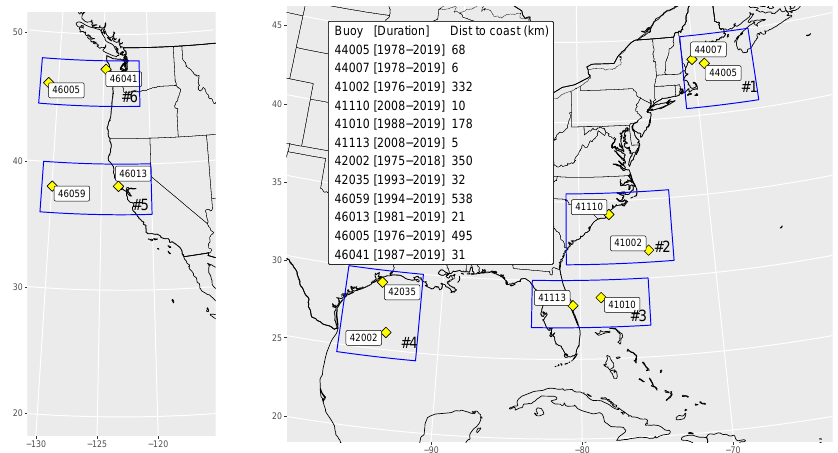
Figure 1. Map of the six regions indicated by blue boxes, and the associated NDBC moored data